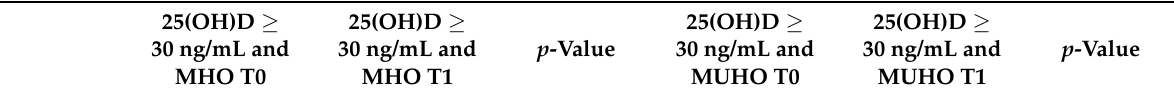
Table 2. Mean or percentage of inadequacy of body and biochemical variables, and presence of chronic noncommunicable diseases considering 25(OH)D < 30 ng/mL together with different metabolic phenotypes before and after Roux-en-Y Gastric Bypass bariatric surgery.